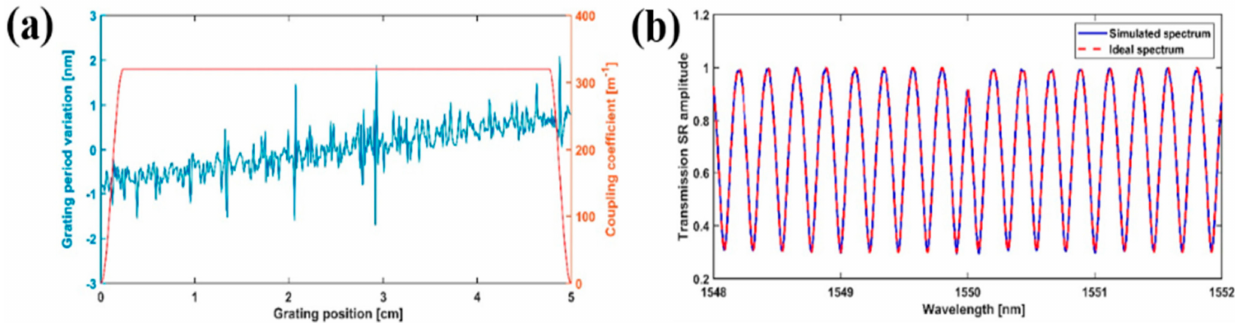
Figure 26. Optimization results of the 1.5th order Hilbert transformer. ( a ) The local change in grating period and coupling coefficient. ( b ) Ideal spectrum (dotted red line) and calculated spectrum. Adapted with permission from ref.